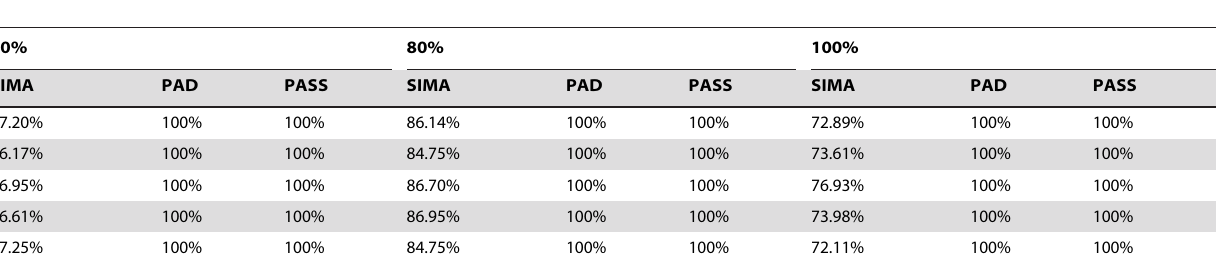
Table 1. Sensitivity analysis of three sets (noise levels 60%, 80% and 100%) for Toy